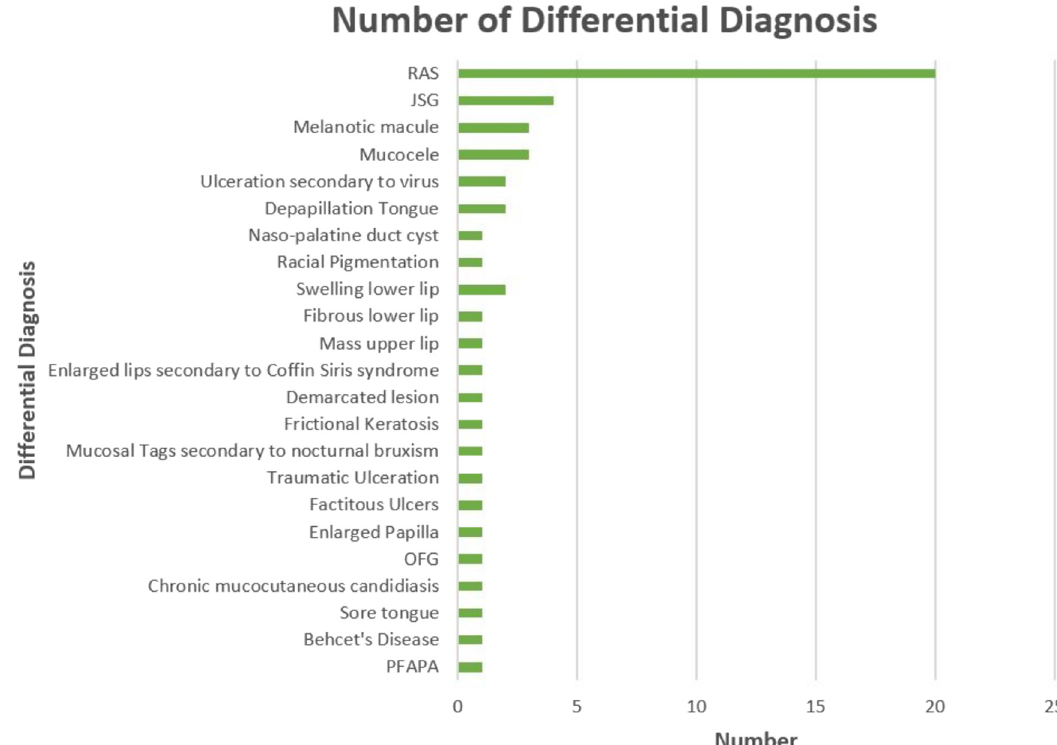
Fig. 1. A graph showing the differential diagnosis of patients reviewed on the